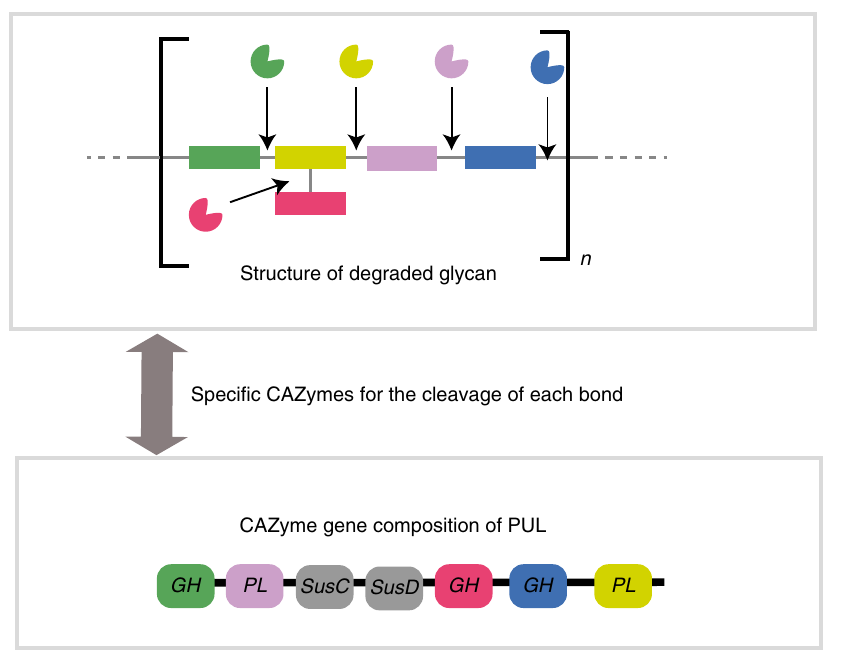
Fig. 1 Schematic view of the approach taken to estimate the number CAZyme combinations in PULs. The depolymerization of a given complex glycan by Bacteroidetes PULs requires bespoke enzymes secreted in the perisplasm and the extracellular milieu. Conversely, the enzyme composition of PULs provides information on the structure of the targeted glycan. The enumeration of PULs according to their composition encoded CAZymes gives an estimate of the diversity of glycans degraded by